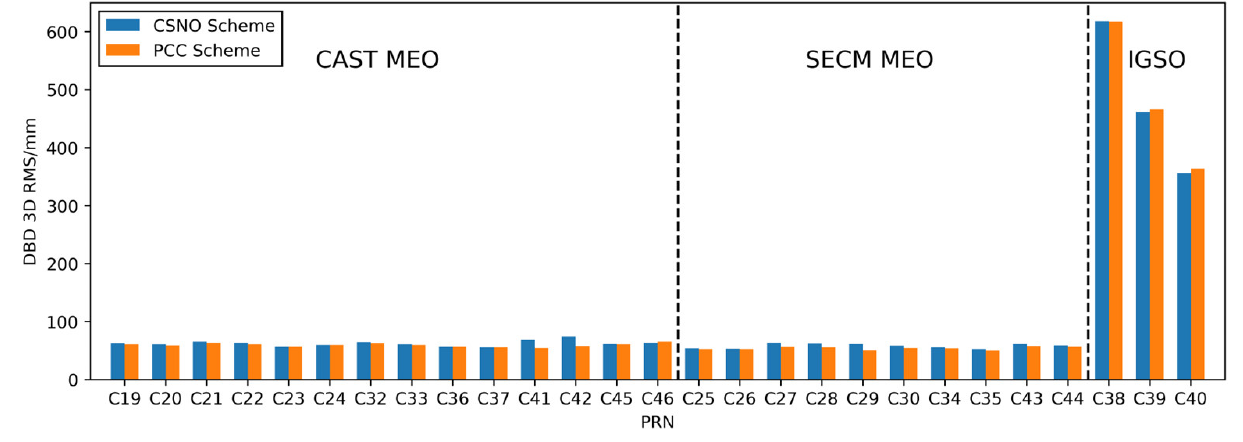
Figure 10. The mean orbit DBD 3D RMS of CSNO and PCC Schemes. Table 6. Orbit DBD 3D RMS difference of each scheme and their comparison, the unit is mm.